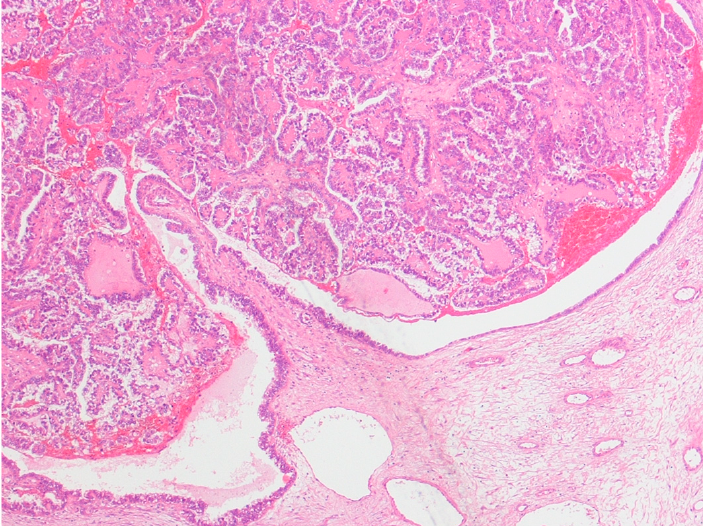
Figure 1. Clear cell carcinoma of the ovary arising in the lumen of an endometrioma, lined by columnar endometrioid cells. Hematoxylin and eosin ×